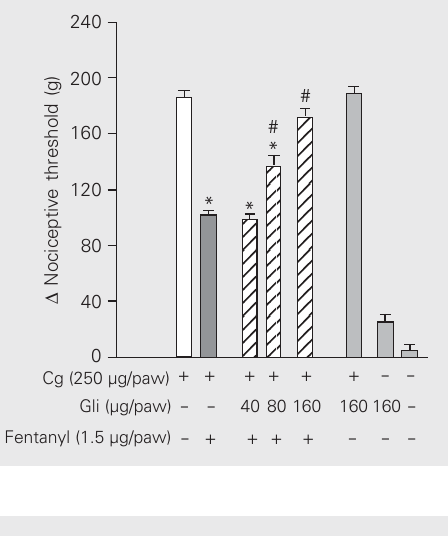
#Figure 4. Antagonism induced by intraplantar administration of tolbutamide of the peripheral anti- nociception produced by fentanyl in hyperalgesic paws. Tolbuta- mide (Tol, µg/paw) was adminis- tered 5 min before fentanyl (1.5 µg). Each column indicates the mean ± SEM (N = 5). The sym- bols “–” and “+” indicate the ab- sence and presence of treatment, respectively. *P < 0.01 compared to carrageenan (Cg) + vehicle-in- jected controls and # P < 0.01 compared to Cg + fentanyl + ve- hicle-injected controls (ANOVA/ Bonferroni’s test).